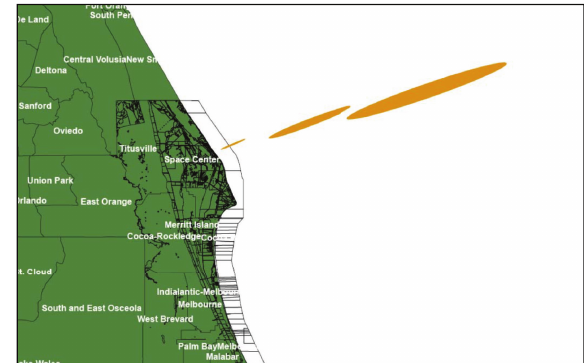
Figure 9: Partial details of a debris model for a spacecraft